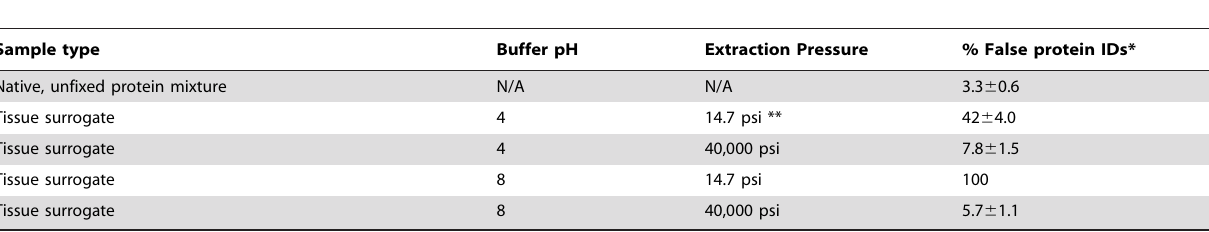
Table 3. Analysis of LC/MS/MS data. Percent of false protein identifications for each sample.